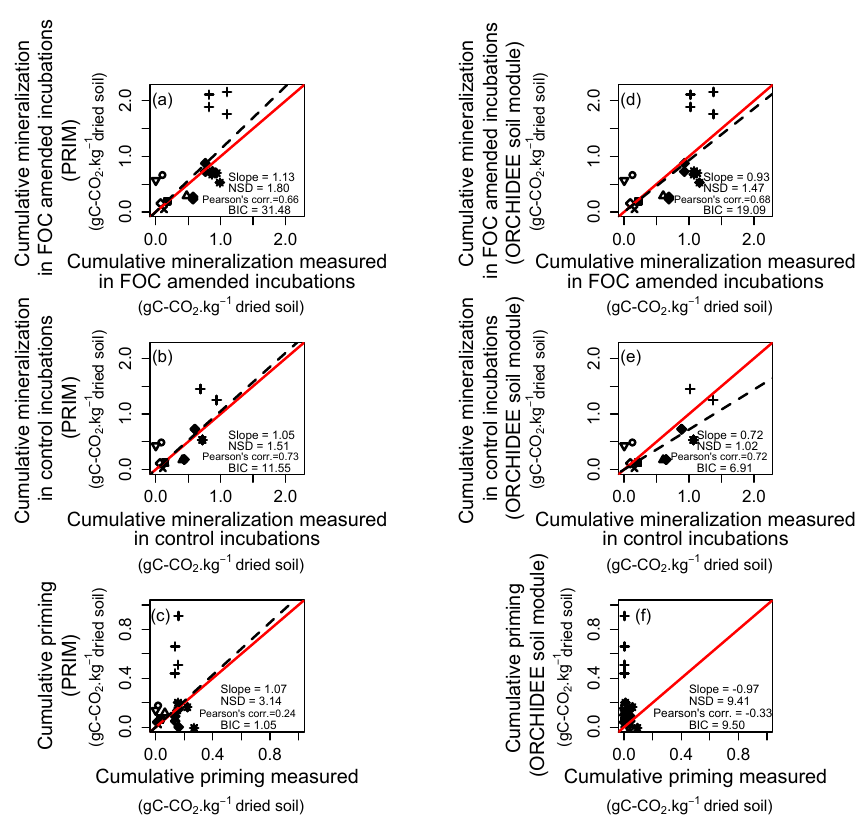
Figure 2. Scatter plot between data and the PRIM model outputs for the incubations with FOC amendment (a) , without FOC amendment (b) and for priming effect (c) . The data sets used here are the similar to those used for optimization (a) or are the control incubations (b) and are described in Sect. 2.2.1. Red lines indicate the 1:1 line. Different symbol indicate different studies.